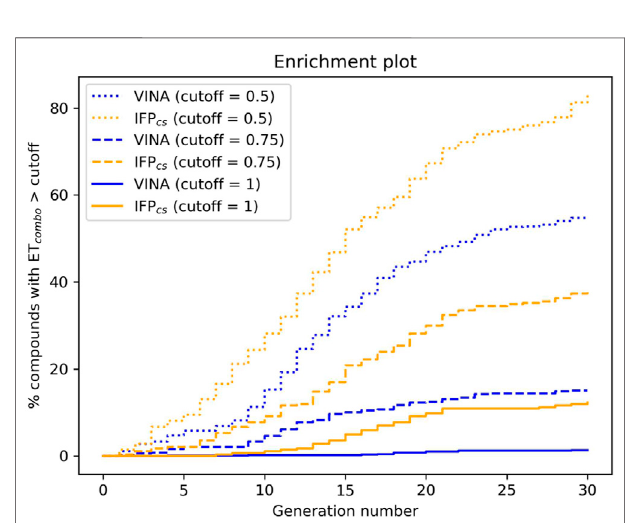
FIGURE 15 | The capability of the two different Autogrow protocols in the prospective de novo run to produce compounds that have a high degree of similarity concerning shape and electrostatic properties to the crystallographic ligands, chosen as reference. For each generation, the percentageofcompoundswithinthetotalpopulationwhose ET combo exceeds a de fi ned threshold value is reported. Three different cutoff values are reported: 0.50, 0.75, and 1.00,